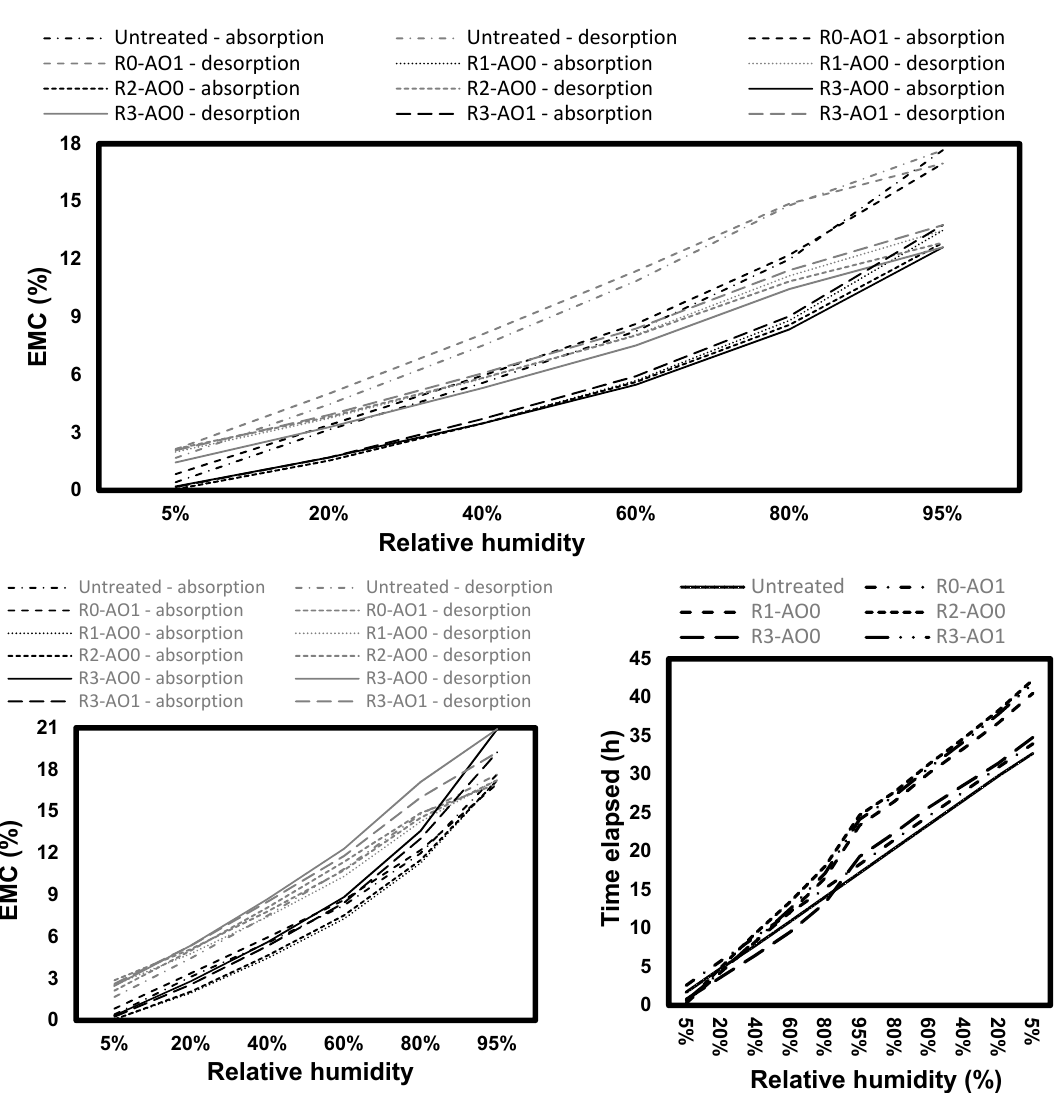
Figure 6. Equilibrium moisture content (EMC) of the samples before ( top ) and after removing the mass of the coatings ( left ), and time elapsed after reaching the equilibrium ( right ) at the different steps during the sorption isotherms in white pine.